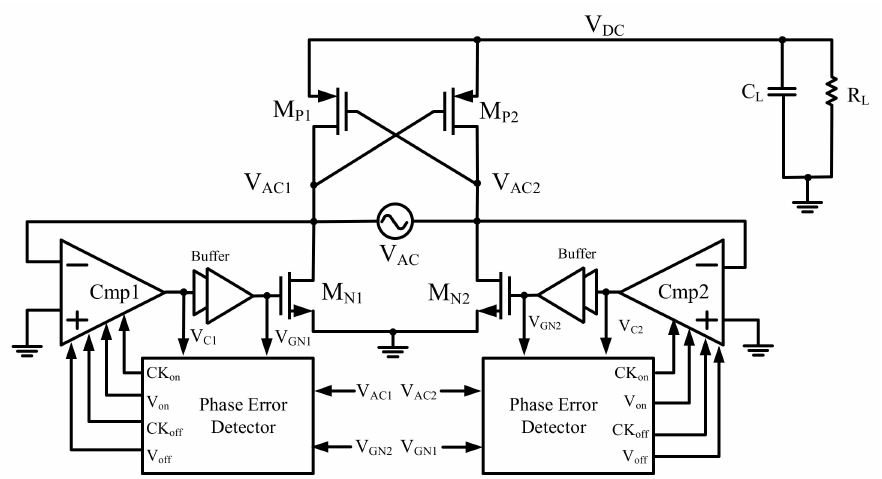
Figure 3. Active rectifier with phase error